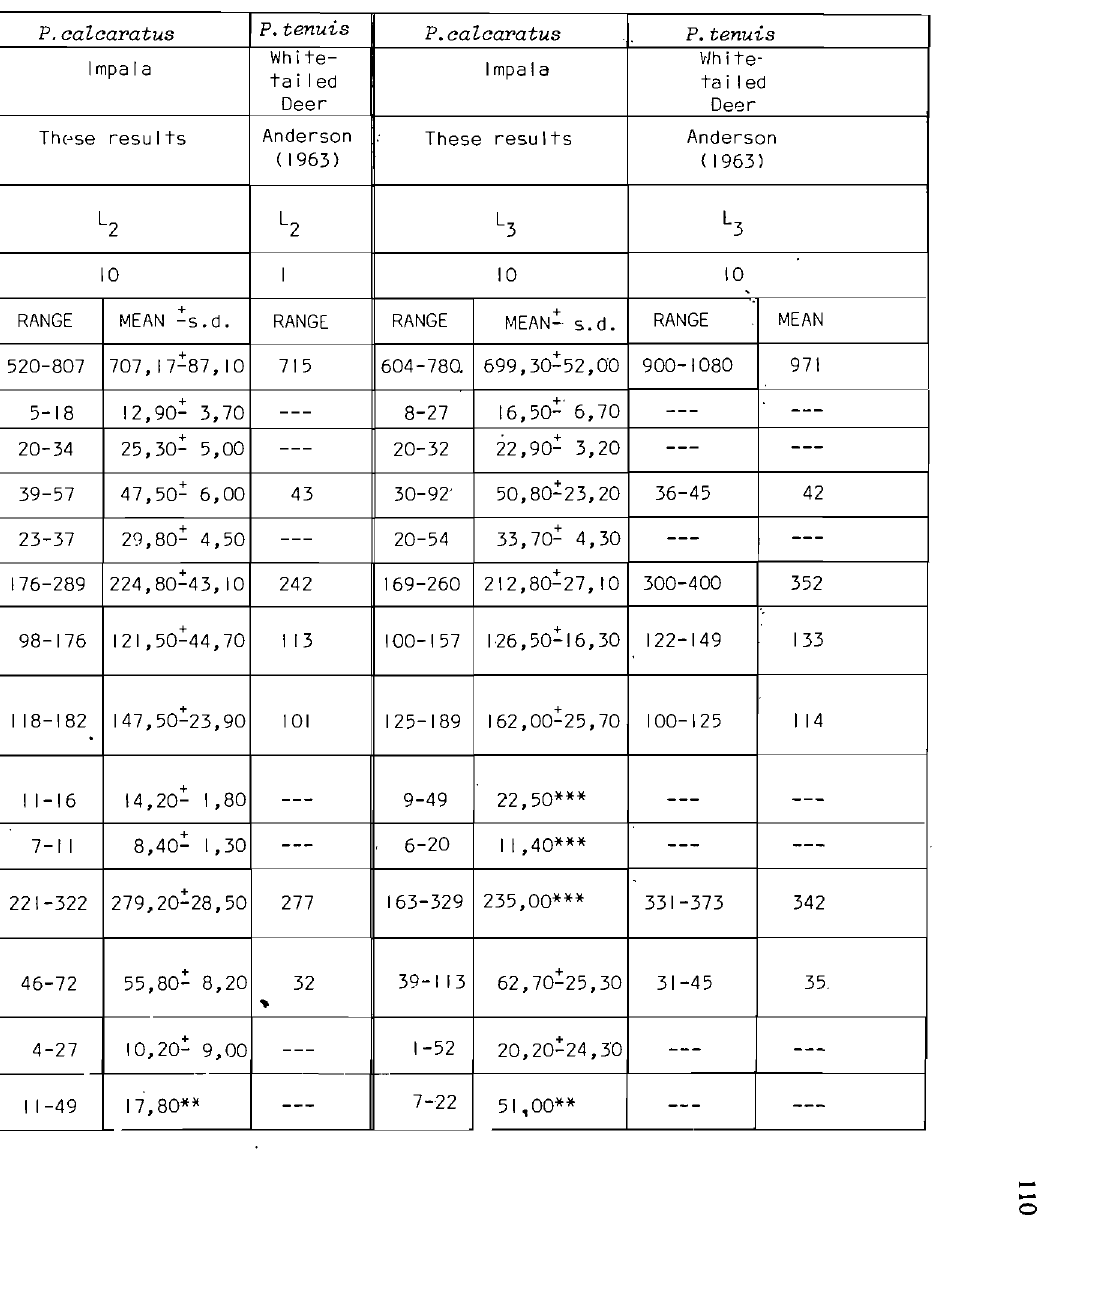
TABLE 1: DIMENSIONS (urn) OF THE L" L2 AND L3 OF PNEUMOSTRONGYLUS CALCARATUS AND PNEUMOSTRONGYLUS TENUIS AND THE L, OF PNEUMOSTRONGYLUS